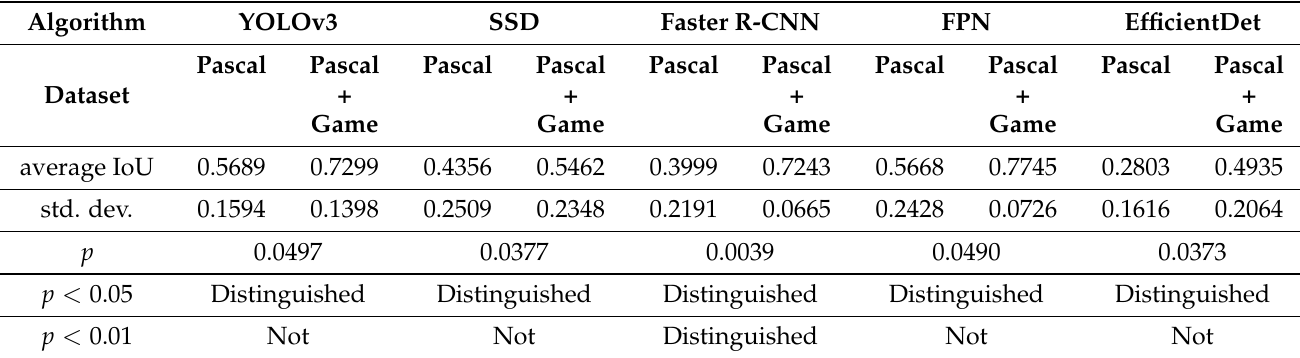
Table 13. p values for the IoUs from four object detection algorithms. We compared the algorithms trained by MS COCO and retrained by MS COCO with game scenes. Note that MS COCO is abbreviated as MS in the table. Algorithm